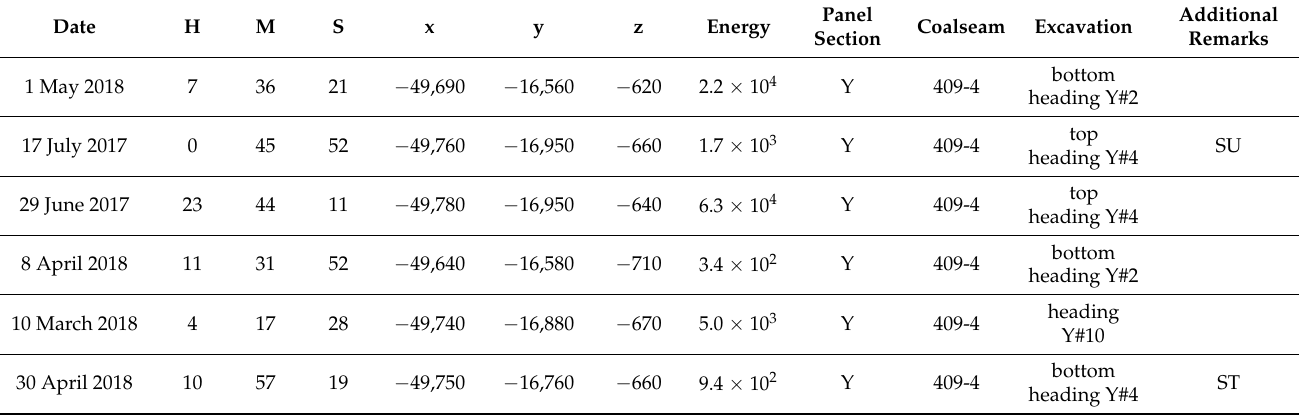
Table 1. Record of seismic